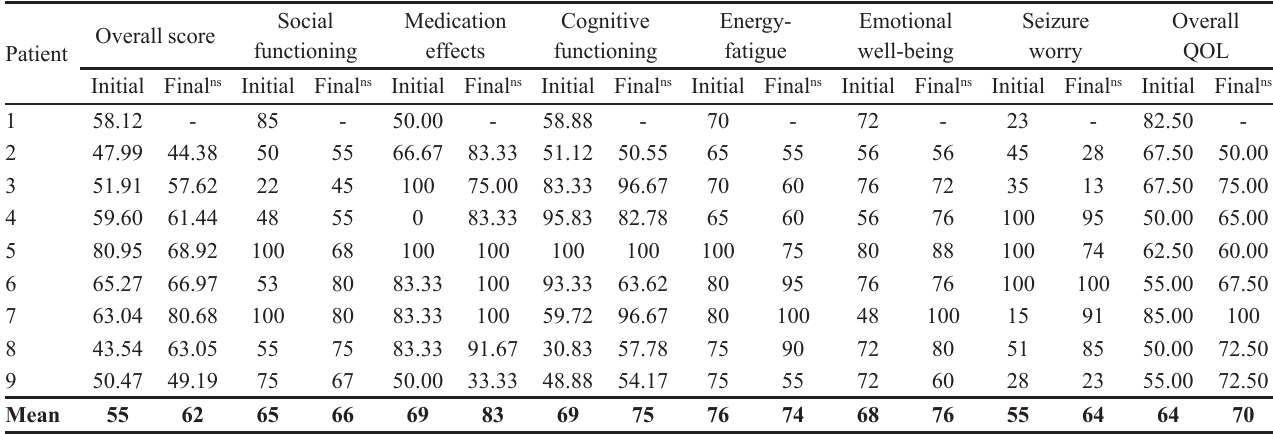
TABLE II - Results (initial versus final) on QOLIE-31 (total and domains) for formulation B